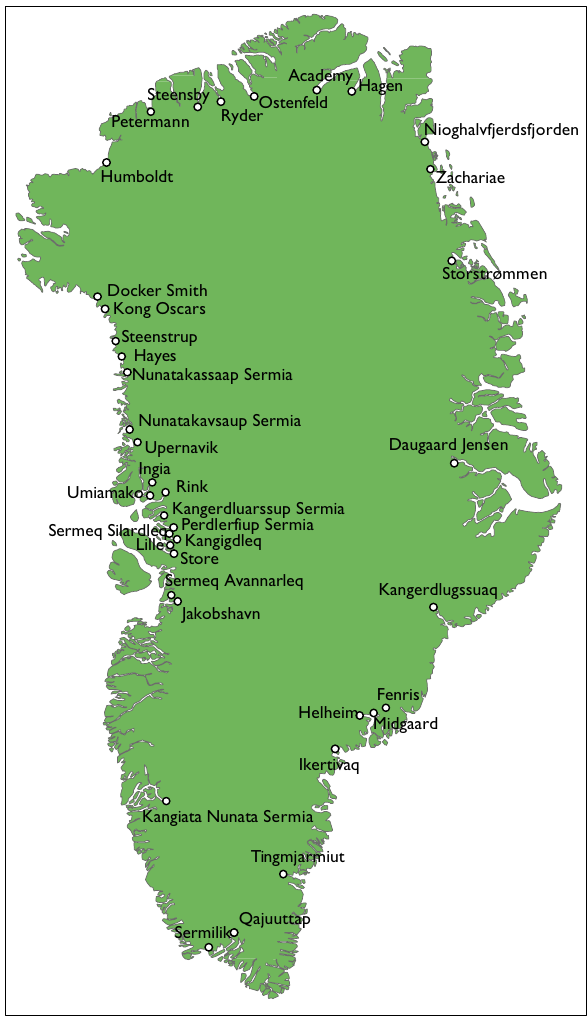
Fig. 1. Location of each of the surveyed outlet glaciers (Table